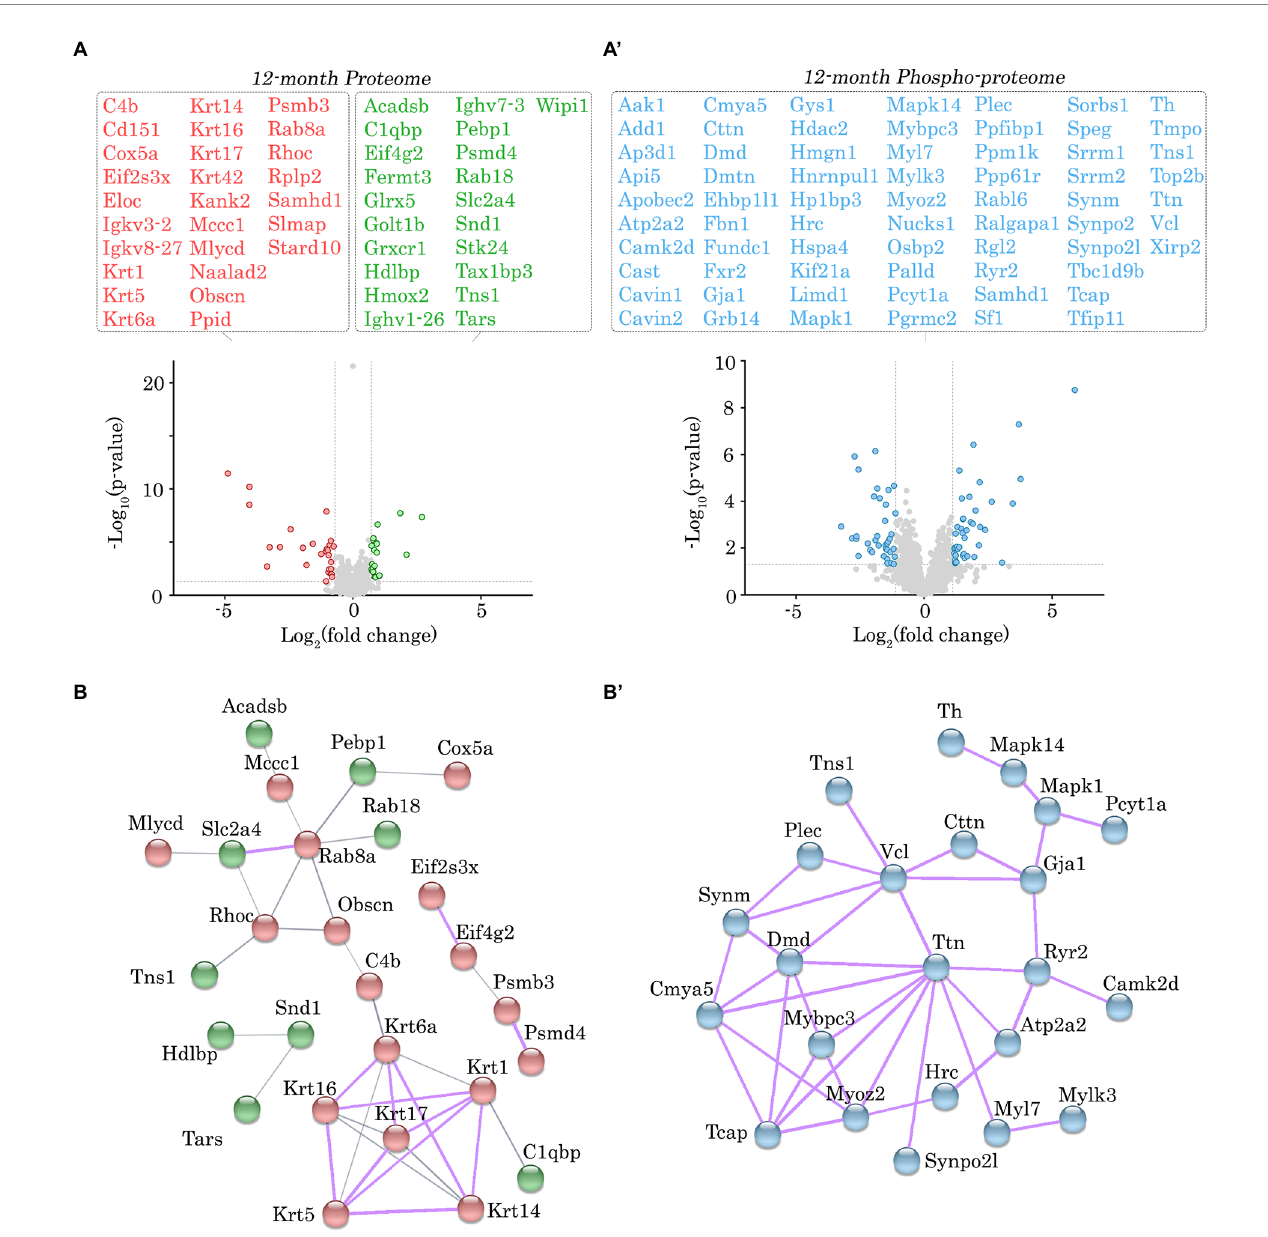
FIGURE 4 Proteomic and phospho-proteomic analysis of Obscn- Δ Ig58/59 atria at 12-months. (A,A’) Volcano plots of significantly up-regulated (green) or down- regulated (red) proteins (A) and significantly altered phospho-peptides (blue; A’ ) in Obscn- Δ Ig58/59 atria at 12-months. A total of 48 proteins out of 1708 detected exhibited significantly altered expression (A) , whereas 78 phospho-peptides out of 2,656 detected were significantly altered (A’) in 12-month-old Obscn- Δ Ig58/59 atria compared to wild-type; n = 5 biological samples per genotype; grey dotted lines represent thresholds of p < 0.05 and SD > 2. (B,B’) The physical and functional associations of the deregulated proteins (B) and phospho-proteins (B’) in Obscn- Δ Ig58/59 atria at 12-months were plotted using the STRING database (v.11.0b). Line thickness corresponds to the strength of the association. Protein networks with a high confidence score (>0.7) are highlighted in